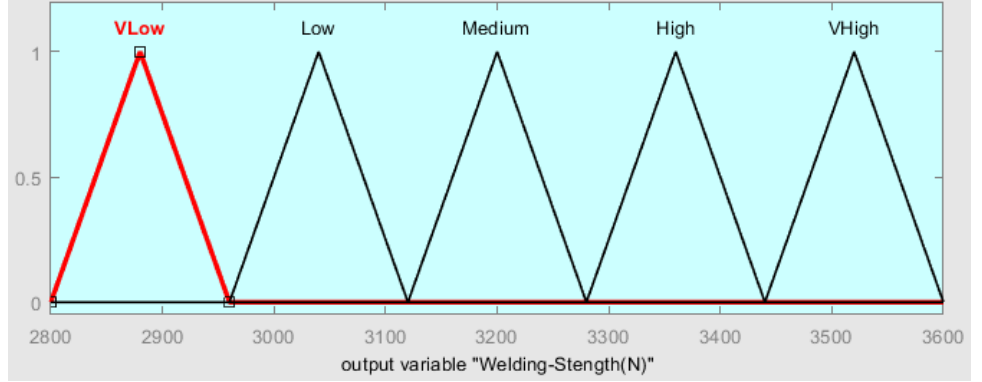
Figure 18. Outputs of FSSW strength (dynamic parameters) fuzzy system. Table 12. Membership functions of FSSW strength fuzzy system output. Table 13. If–Then rules of FSSW strength fuzzy systems.